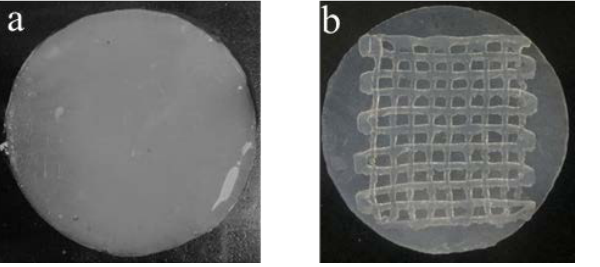
Figure 1. Appearance of SA/CMC-Na hydrogel membranes fabricated by our pneumatic extrusion printing system, ( a ) one layer as a basilar membrane and ( b ) three layers as a scaffold (two layers reticular scaffold and 1onelayer basilar membrane).